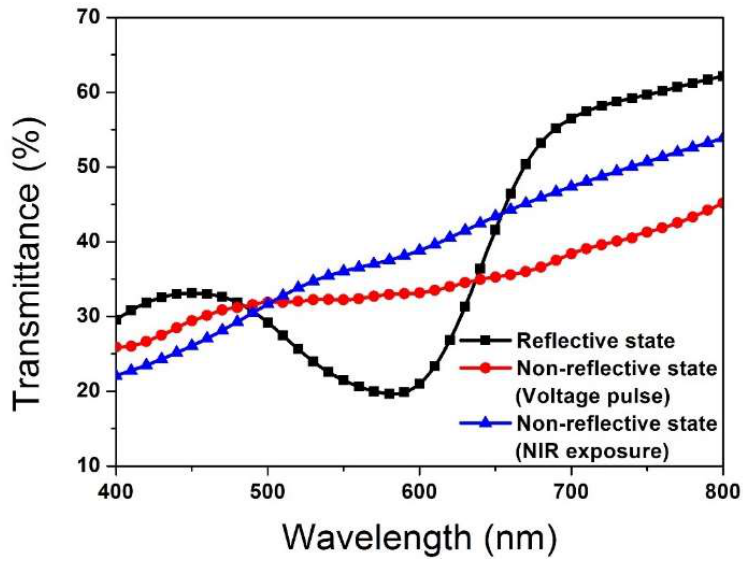
Figure 6. UV transmittance spectra of sample 7 at the reflective state and non-reflective state (induced by voltage pulse and NIR).